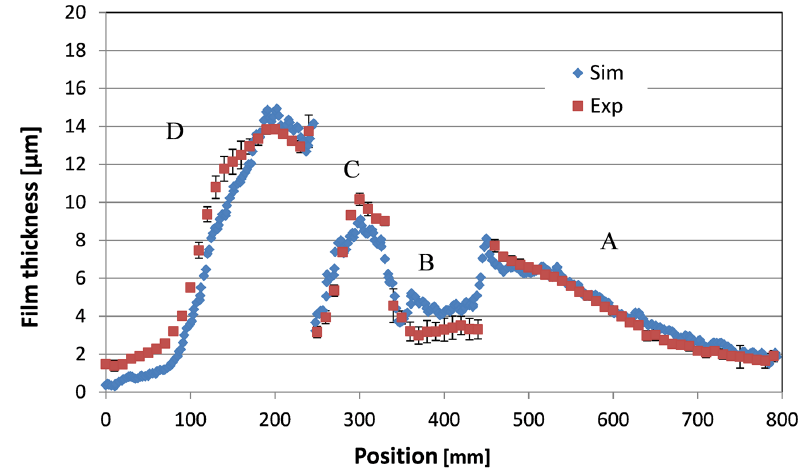
Figure 13. Comparison of the measured and simulated dynamic film thickness distributions (shaping air flow rate: 360 L/min).